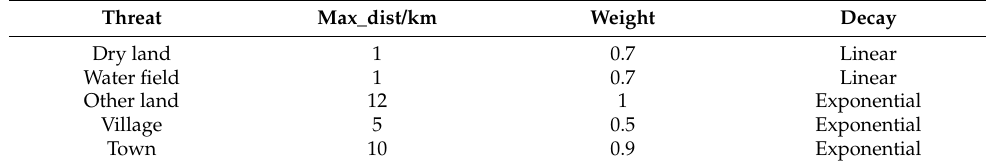
Table 2. The impact distance, attenuation mode, and weight of the threat source.